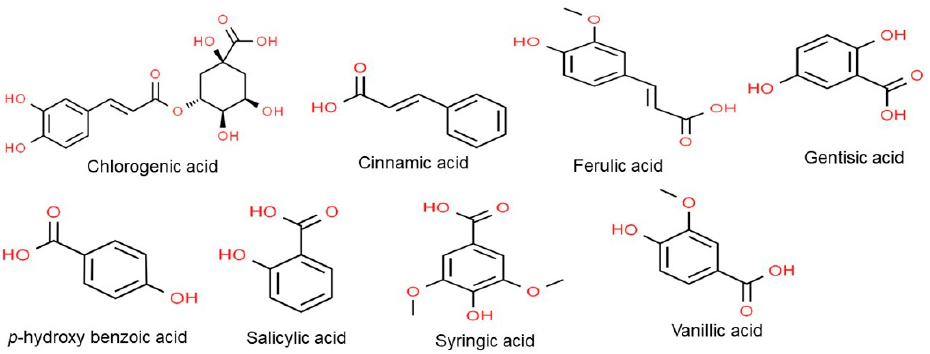
Figure 3. Chemical structure of the major classes of phenolic acids. Structures were drawn using Chem Spider